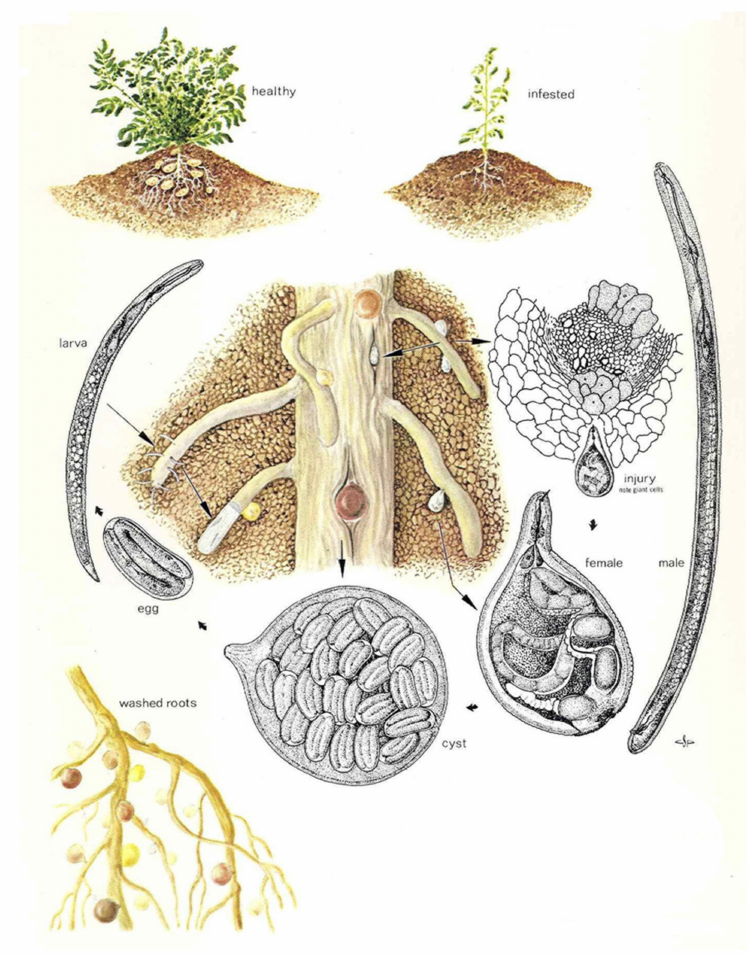
Figure 1. Illustration of the life cycle of Globodera rostochiensis (modified after Charles S Papp, Exclusion and Detection, Plant Pest Detection Manual 5:1, California Department of Food and Agriculture, Division of Plant Industry,